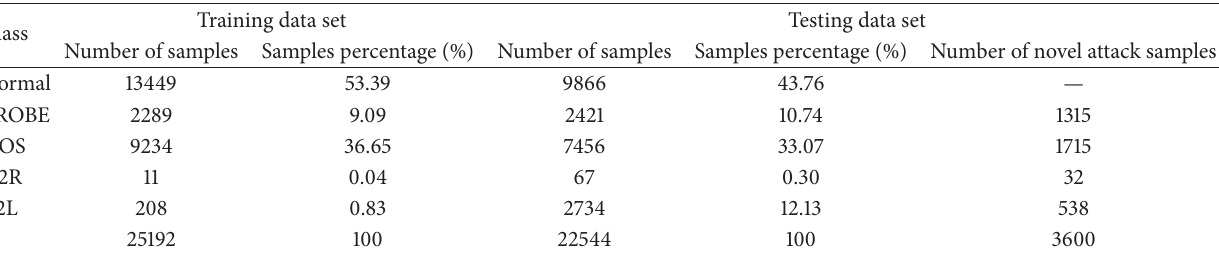
Table 3: The sample distributions on the training and testing data sets with the corrected labels of NSL-KDD data set. Training data set Testing data set Class